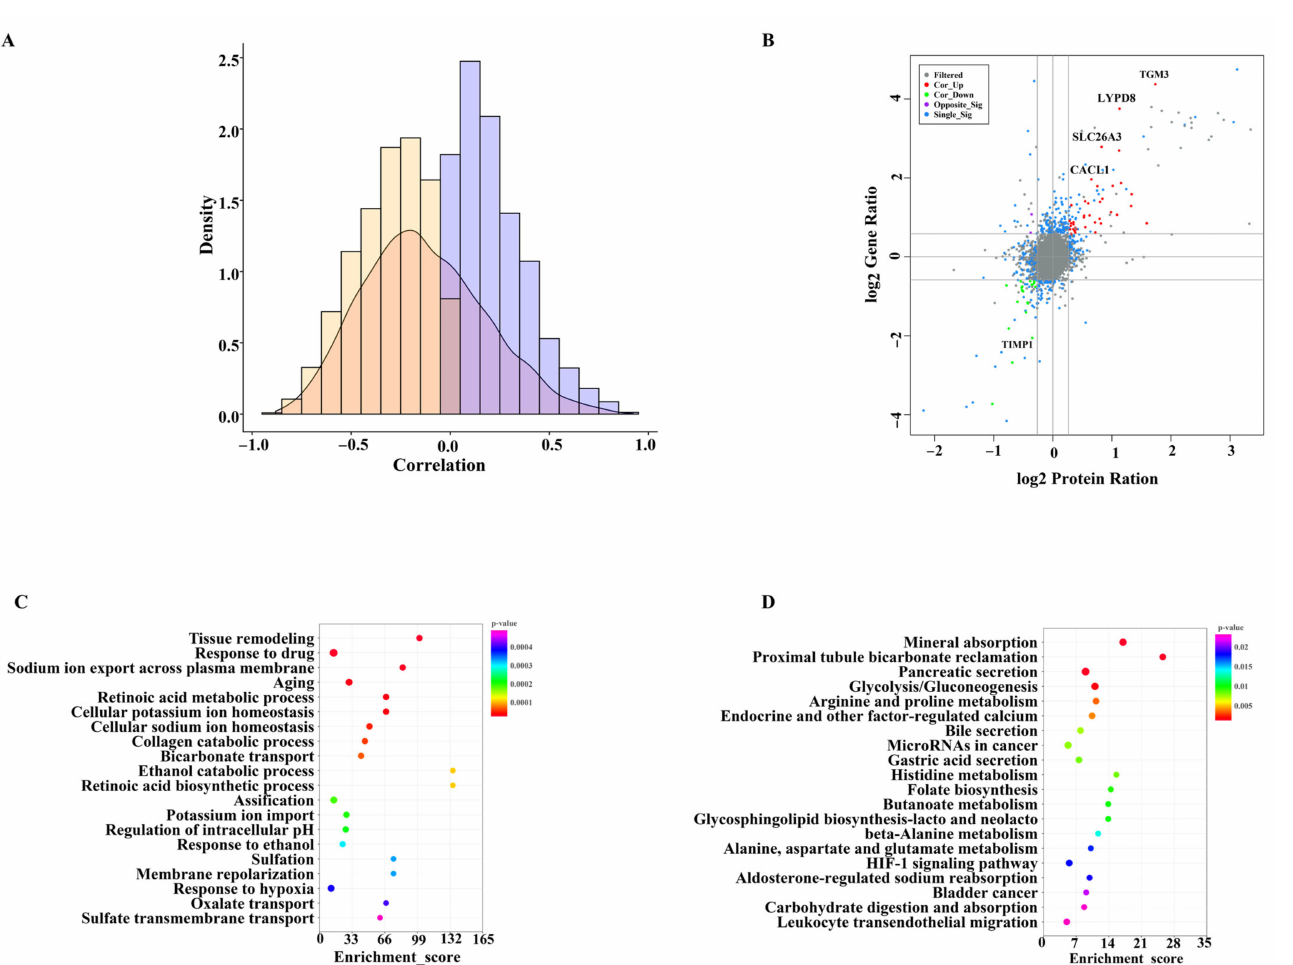
Figure 5. Correlation analysis of mRNA and protein levels. ( A ) The combination results of def- erentially expressed genes and proteins. ( B ) Distribution of Spearman correlation coefficients of mRNA − to − protein abundance in the colon. ( C ) GO terms in the biological process category of the differentially expressed mRNA − proteins. ( D ) KEGG pathway analysis of differentially expressed mRNA −